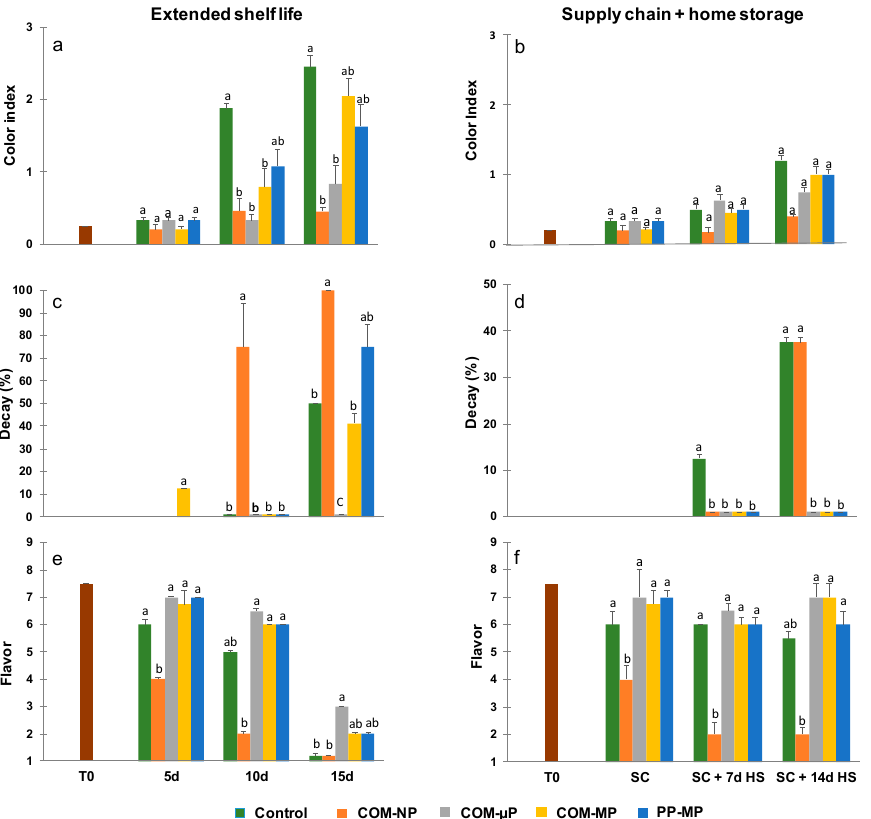
Figure 7. Color indices, decay levels, and flavor scores of cucumbers kept in different types of packaging. Measurements were taken during continuous storage under shelf conditions at 22 ◦ C (Extended shelf life) and after the simulated farm-to-fork supply-chain treatment (2 days at 15 ◦ C + 2 days at 22 ◦ C) plus 1 or 2 weeks of refrigerated home storage at 4 ◦ C (Supply chain + home storage). Figures ( a ) and ( b ) represent color indices; Figures ( c ) and ( d ) represent decay precentages, and Figures ( e ) and ( f ) represent flavor acceptance scores after extended shelf life and farm-to-fork supply-chain conditions, respectively. Data are means ± SE of 3 replications. Different letters indicate significant differences at p ≤ 0.05. COM—compostable, PP—polypropylene, µ P—micro-perforated, MP—macro-perforated, NP—non-perforated.